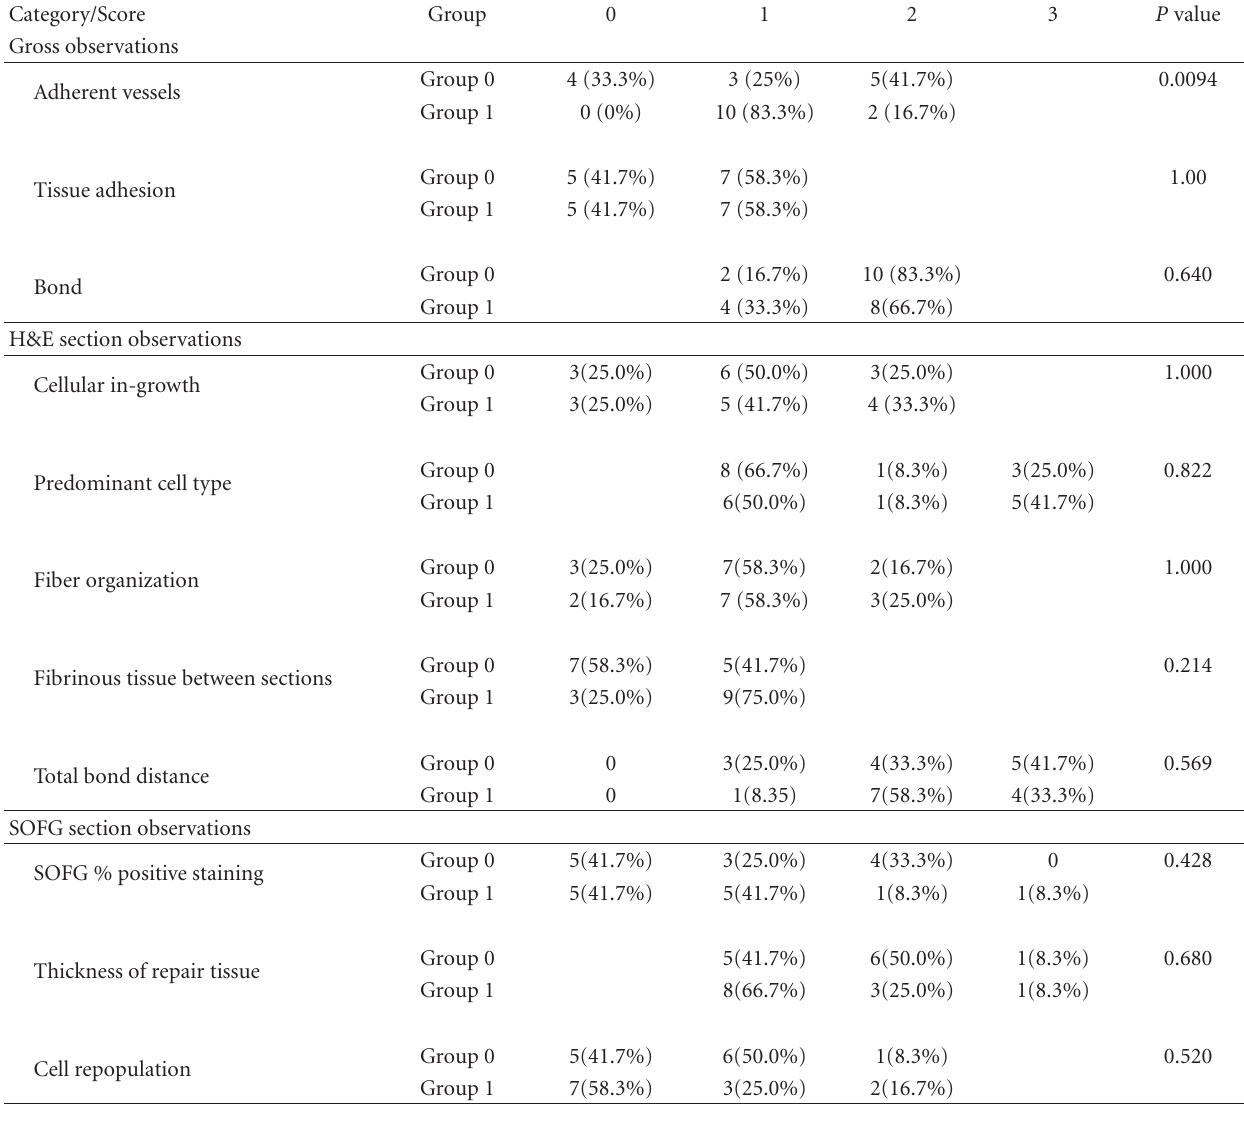
Table 2: Group 0 is fibrin only treatment; Group 1 is fibrin with BMSCs treatment. See Table 1 for grading score rubric.